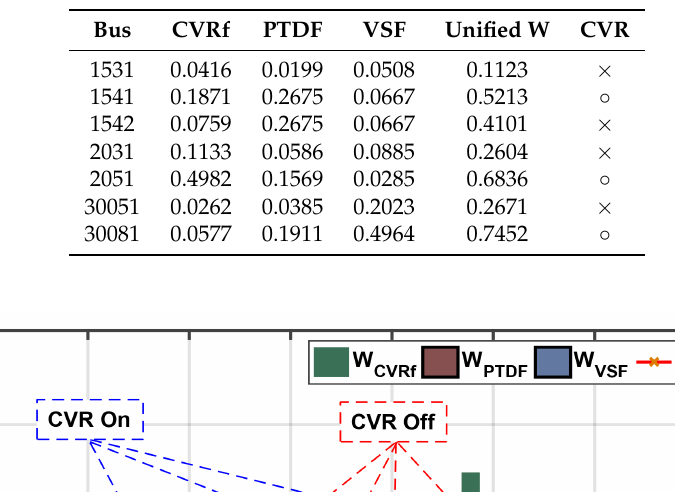
Table 5. Weighting factors for each factor and unified weighting factors obtained from AHP.